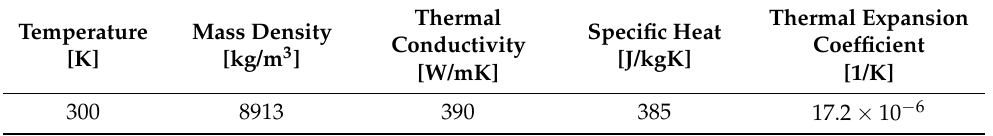
Table 5. Physical properties of electrodeposited OFHC Cu [24].